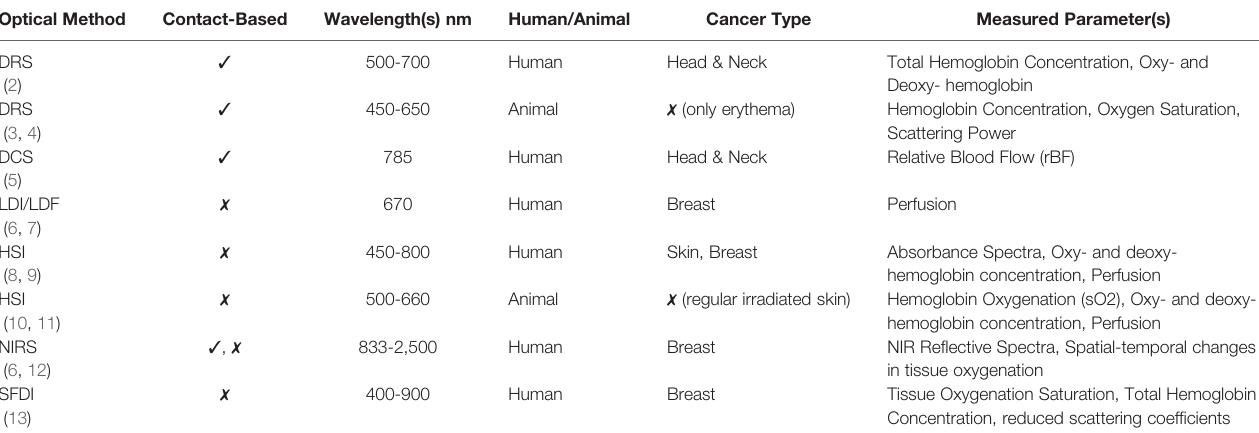
TABLE 1 | Optical imaging studies related to radiation dermatitis. Optical